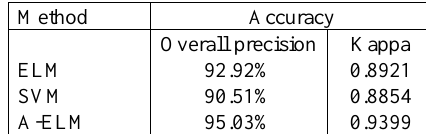
Table 6. Accuracy comparison on Hamburg image experiment